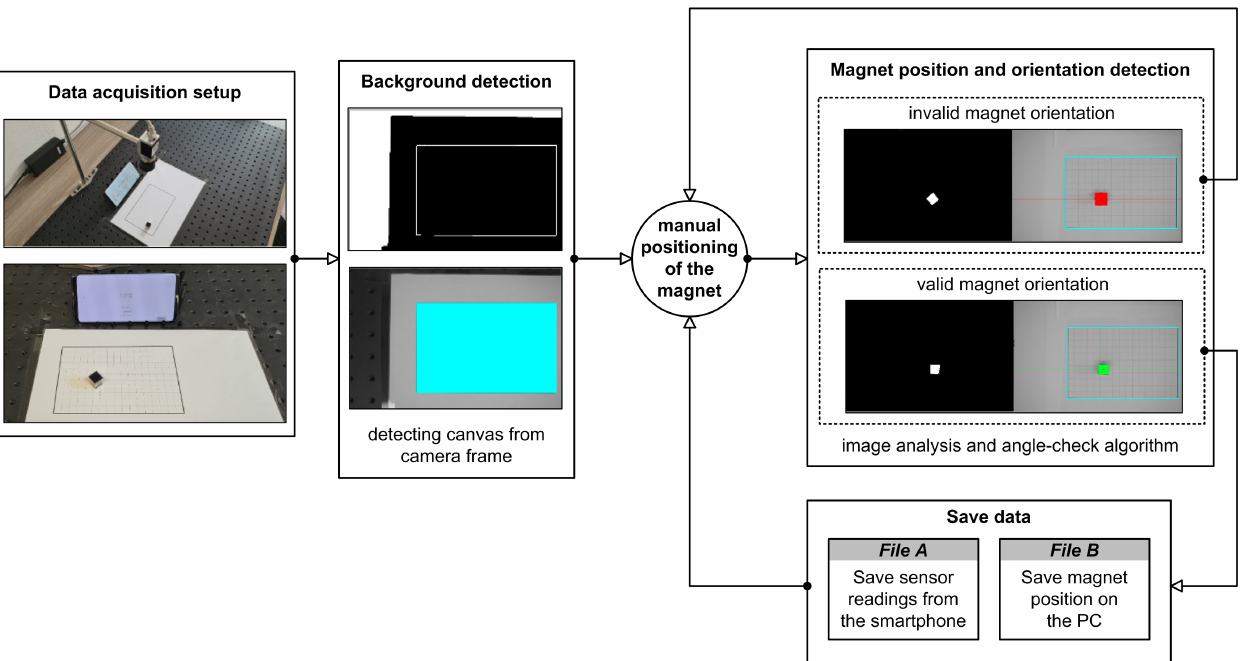
Figure 8. The process of dataset acquisition for the NN